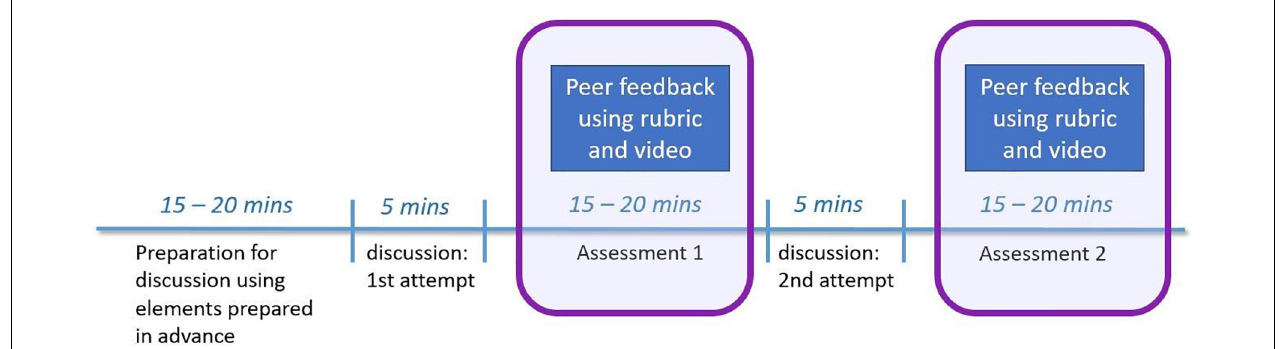
FIGURE 1 | Preparation and the two iterations of the first pair’s